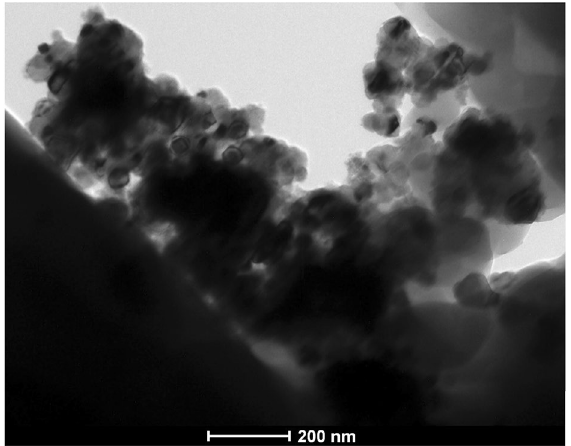
Figure 8. TEM micrograph of Ni–P-2.0 g L −1 TiC presenting the agglomeration of the particles in the Ni–P